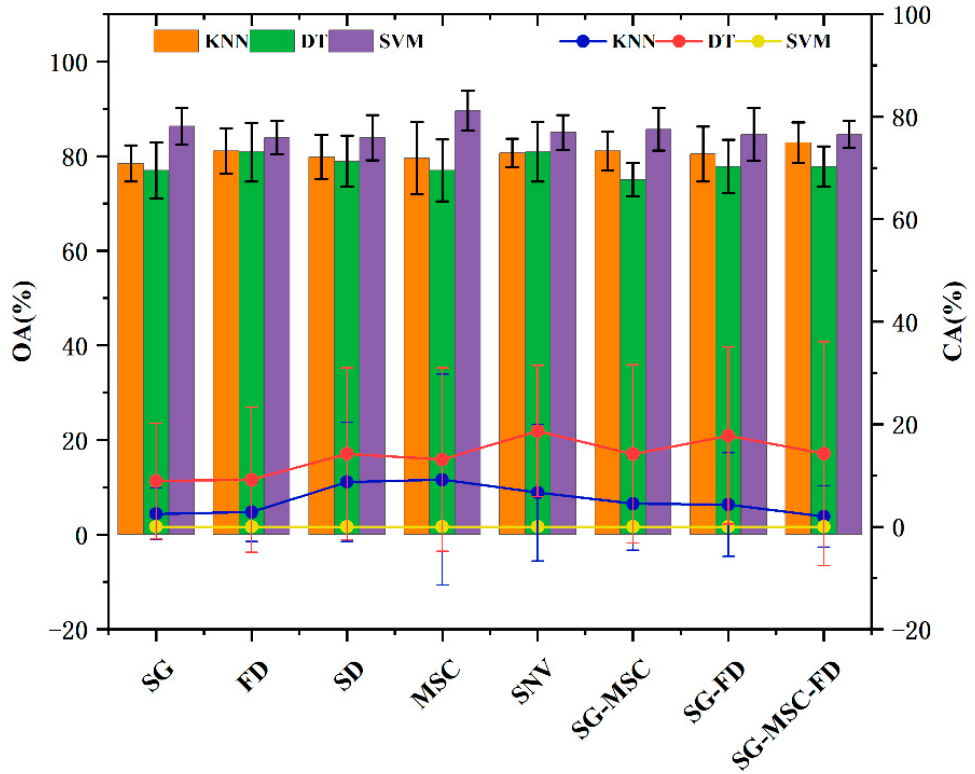
Figure 1. Analysis of the OA and CA of eight pretreatment methods.